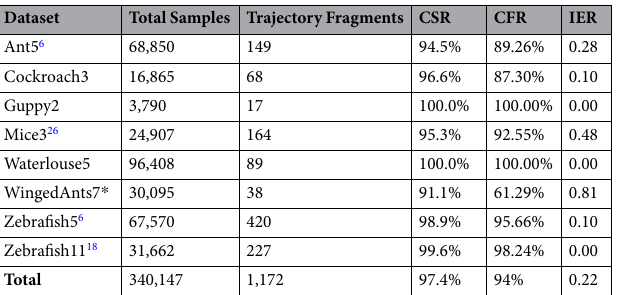
Table 2. Results of the analysis. ( * ) dataset provided by the department of evolutionary biology and environmental studies from the University of Zurich. The original video can be downloaded at http://www.